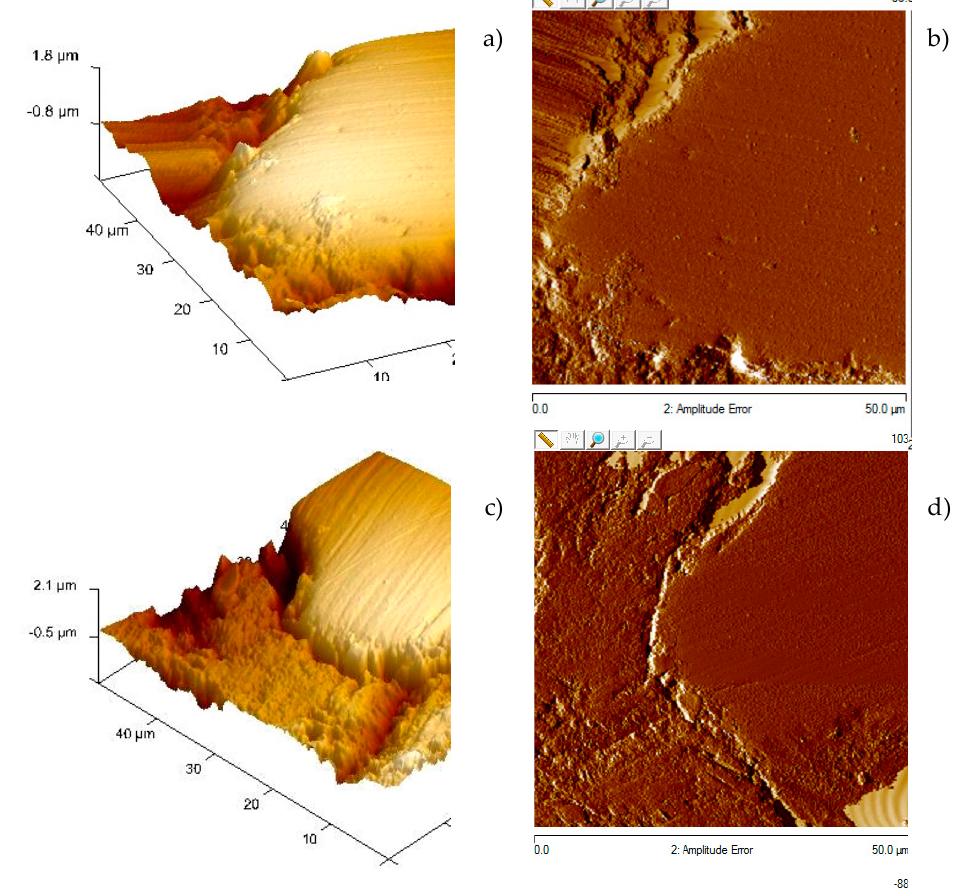
Figure 11. ( a ) Graphical representation of the topography sample with limestone aggregate, ( b ) changes of its phase in the interface, ( c ) graphical representation of the topography sample with GBFS, ( d ) changes of its phase in the interface